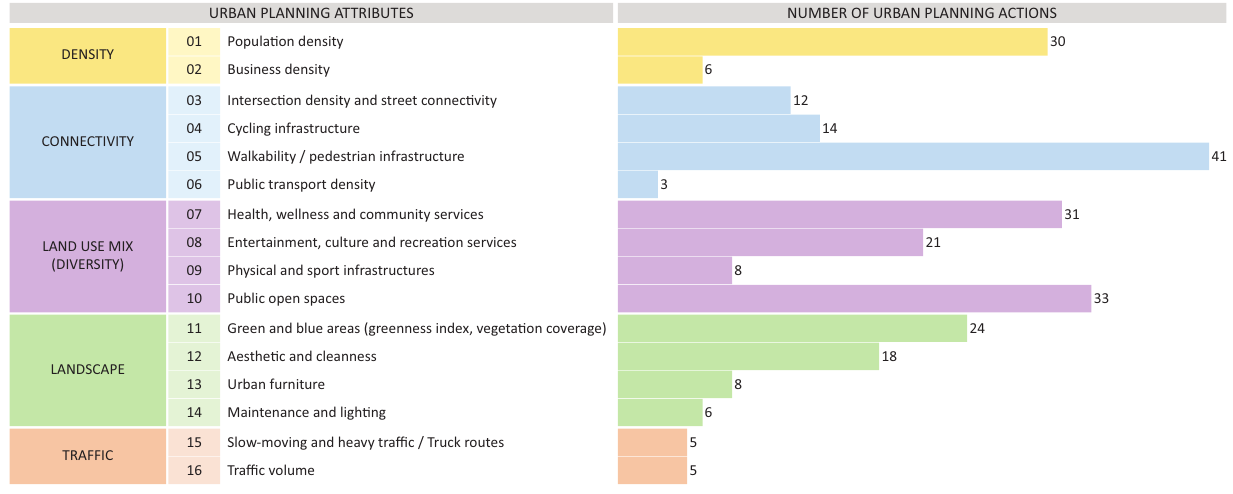
Figure 8. Overview of the number of urban planning actions included in the Vic urban master plan that relate to the health‐ related urban planning attributes.